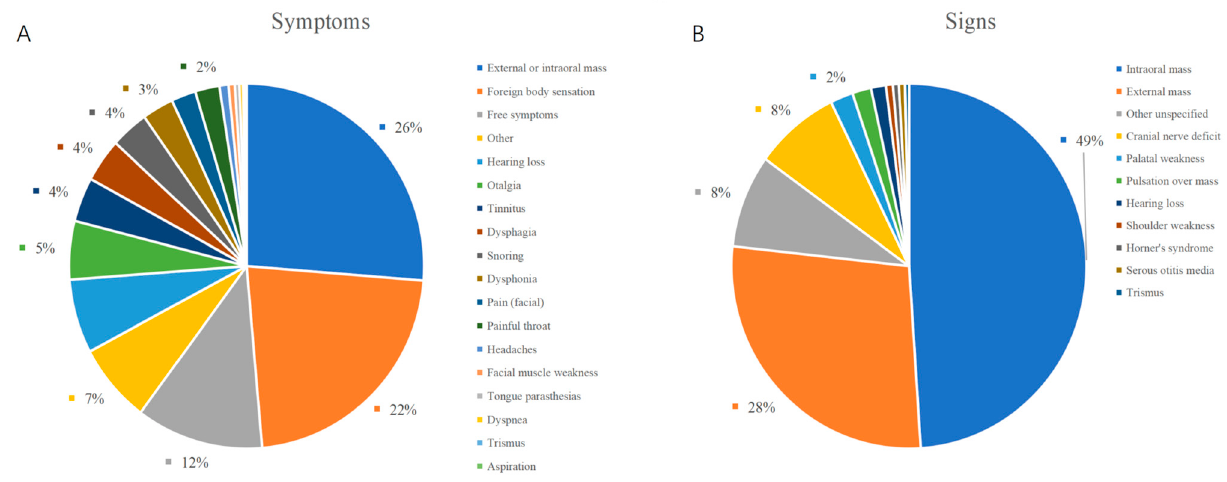
Figure 2. Distribution of the symptoms and signs of PPS lesions. ( A ) symptoms; ( B ) signs.